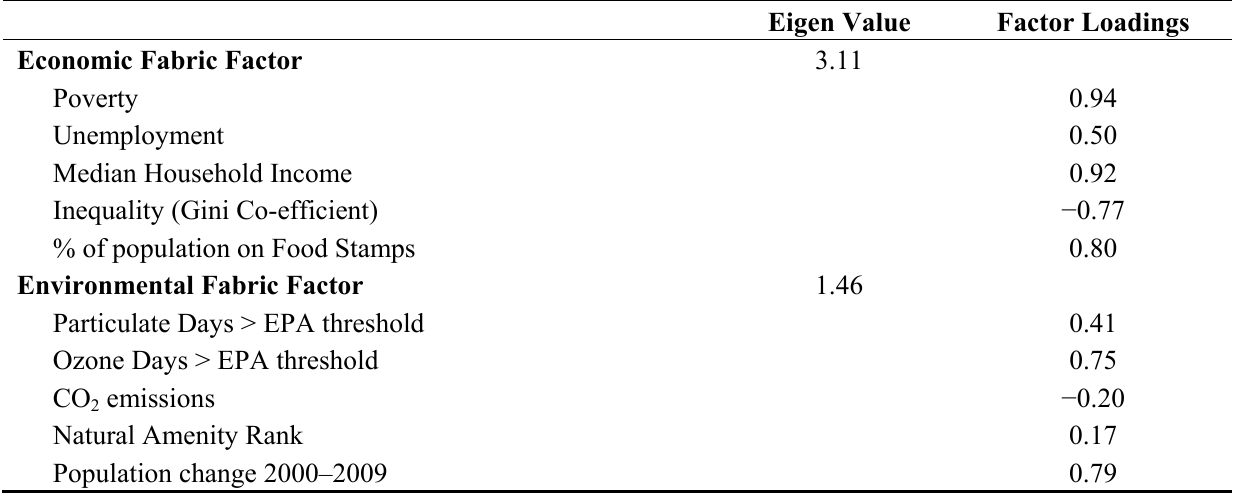
Table 1. Factor analysis results for fabric indicator.